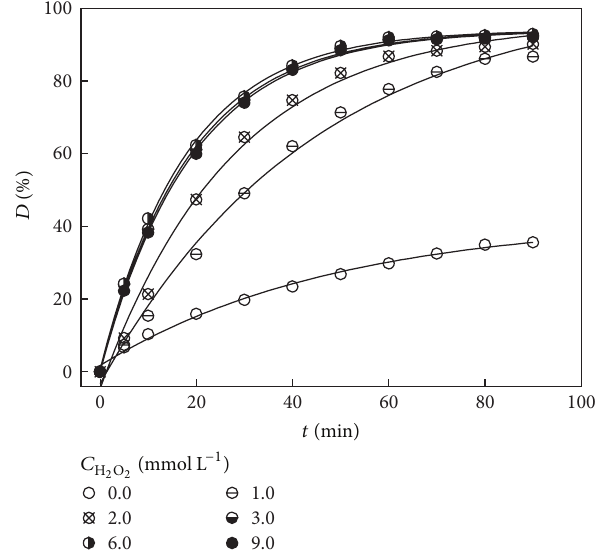
Figure 6: Effect of H 2 O 2 initial concentration on degradation of RR